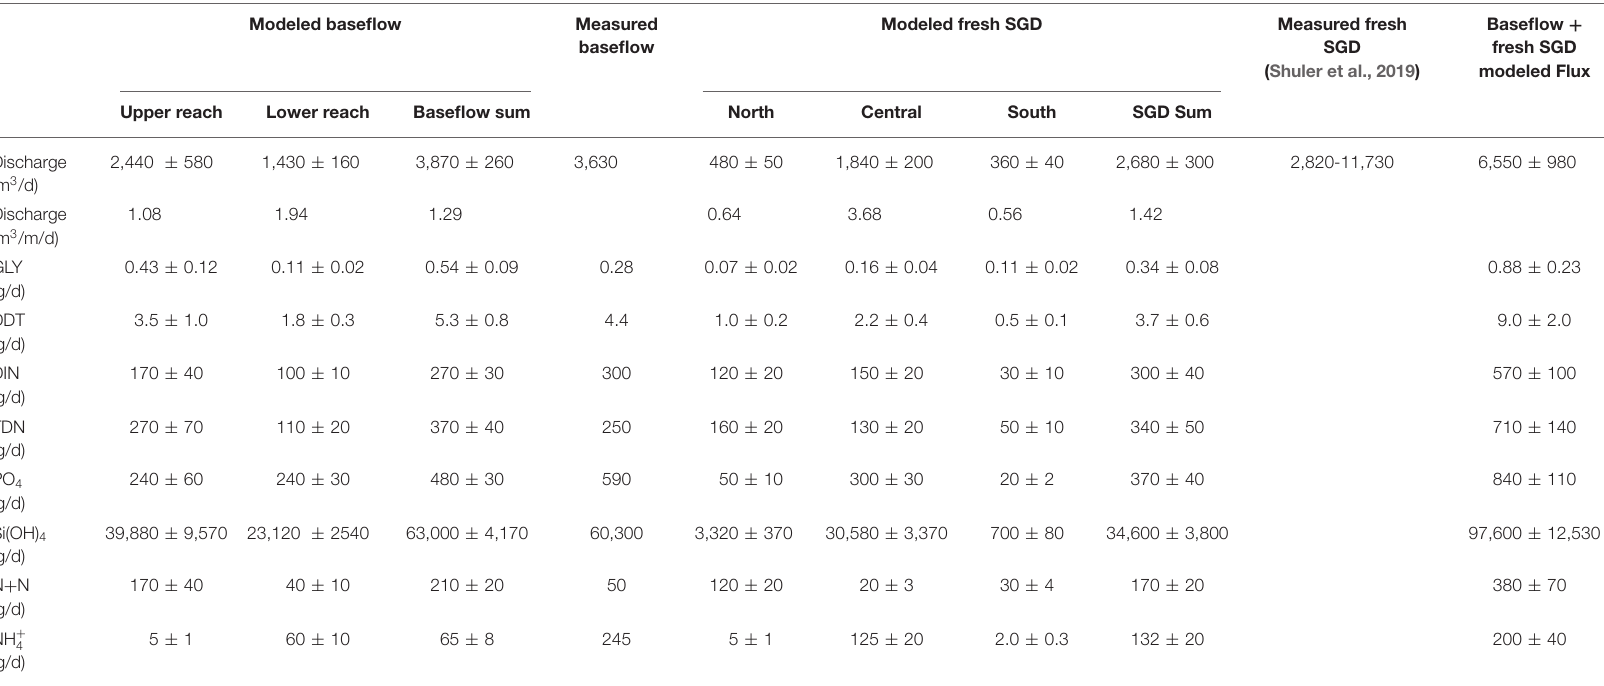
TABLE 5 | Modeled groundwater discharge via stream baseflow and fresh SGD, and their associated pesticide and nutrient fluxes based on observed concentrations in each representative section of the